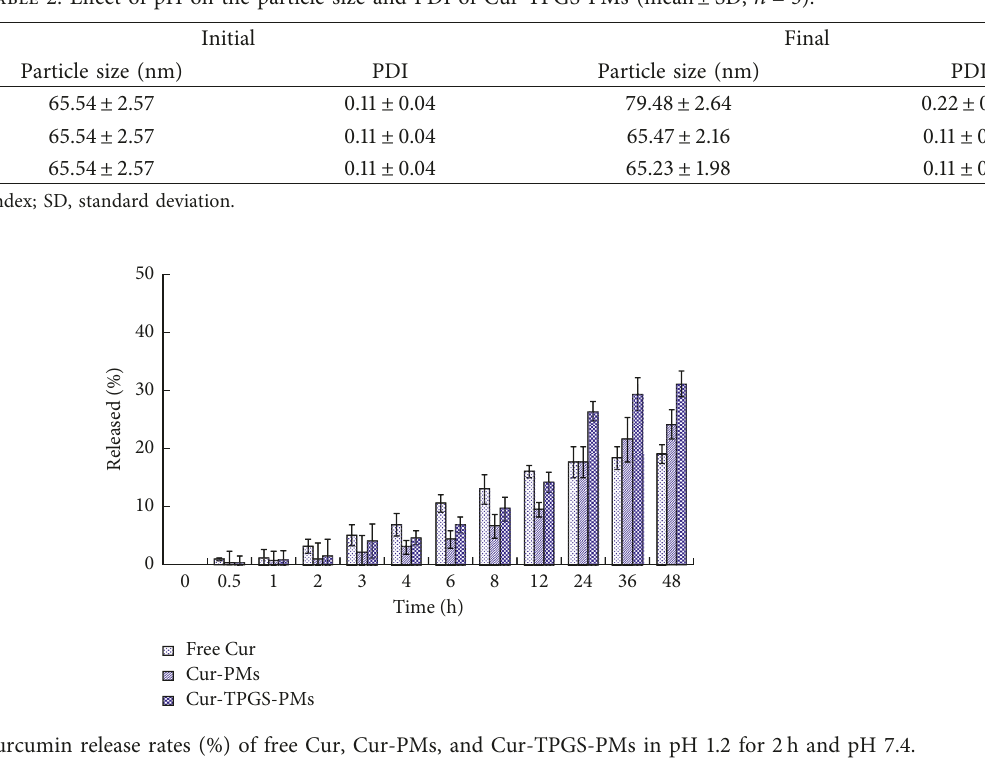
Table 2: Effect of pH on the particle size and PDI of Cur-TPGS-PMs (mean